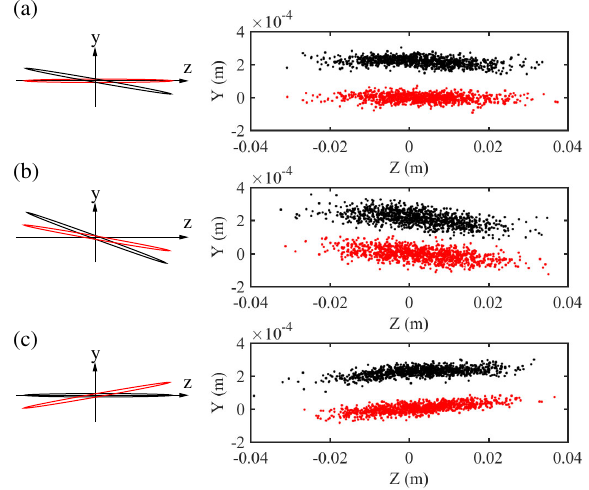
FIG. 10. Right: Particle distributions in the yz plane from simulations for the e − lattice lat − ð 0 Þ . Left: Cartoons showing the beam tilt in the yz plane. Red: top scraper retracted. Black: Top scraper inserted. The coupling bump is set to (a) cp 11 ¼ 0 , (b) cp 11 ¼ þ 10 k, and (c) cp 11 ¼ − 10 k with a bunch current of 1 mA. FIG. 11. Measured vertical beam size σ y versus current for the